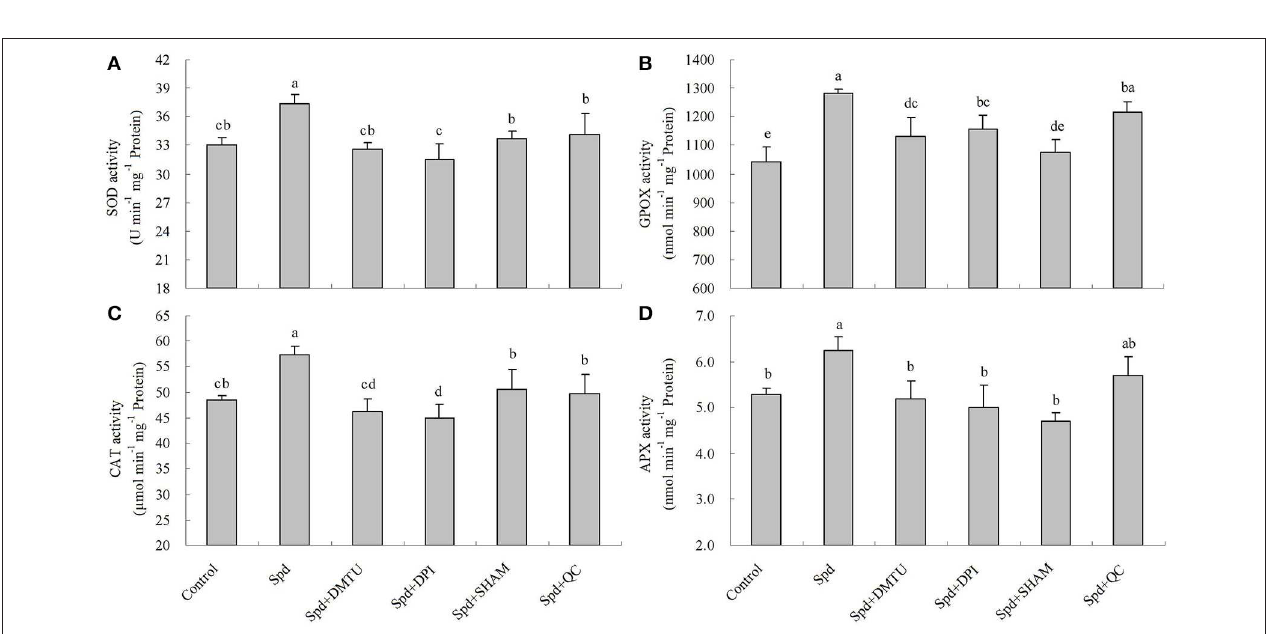
FIGURE 10 | Spd-induced SOD (A), GPOX (B), CAT (C), and APX (D) activities were dependent on hydrogen peroxide (H 2 O 2 ) signaling. The detached leaves of white clover were pre-treated with distilled water for 1h to eliminate wound stress and then treated for 8h as follows: 1, distilled water (control); 2, 20 µ M Spd; 3, 20 µ M Spd + 5mM dimethylthiourea (DMTU); 4, 20 µ M Spd + 100 µ M Diphenyleneiodonium (DPI); 5, 20 µ M Spd + 5mM salicyhydroxamic (SHAM); 6, 20 µ M Spd + 100 µ M quinacrine (QC). Means of six independent samples are presented. Bars represent standard errors. The same letter indicates no significant difference (LSD) at P <